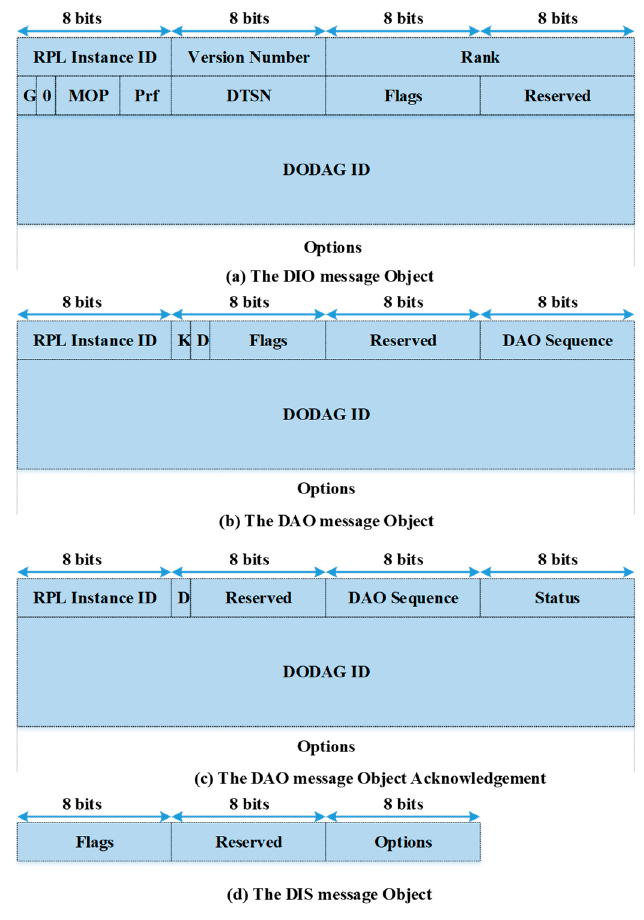
Figure 2. Formats of RPL control messages.